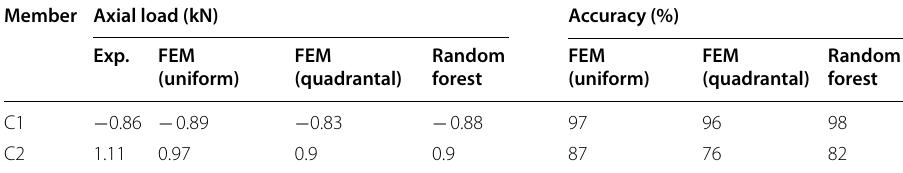
Table 5 Comparison of modeling approaches Member Axial load (kN) Accuracy (%) Exp. FEM FEM Random FEM FEM Random (uniform) (quadrantal) forest (uniform) (quadrantal)